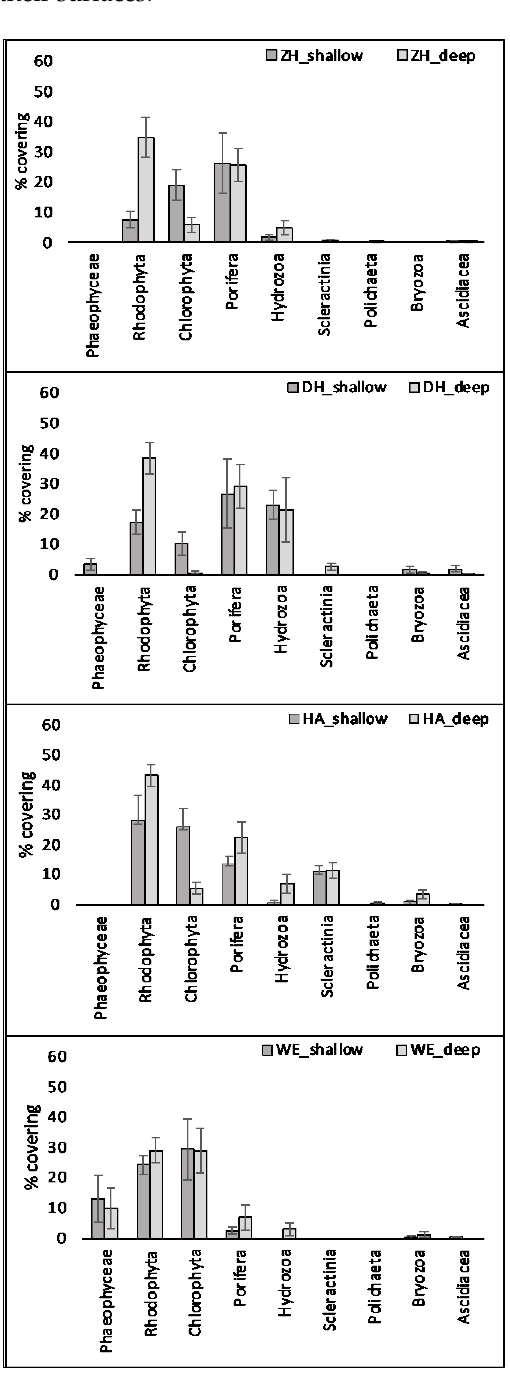
Figure 4. Percentage of covering values (mean ± SD) of the main epibenthic taxa at each study site. ZH = Zhapovel Bay, DH = Cape of Dhim Kushta, HA = Haxhi Ali Cave, and WE = Cape of Gjuhezes.